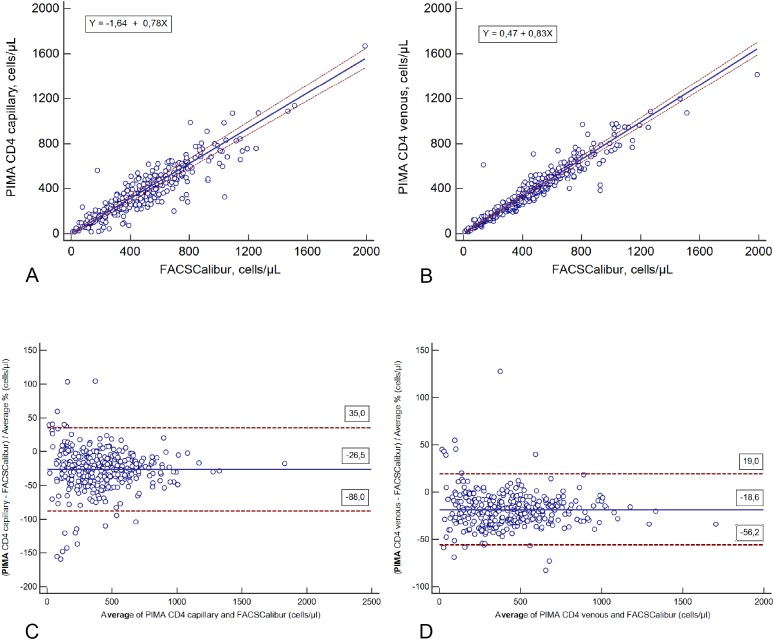
Comparison between the PIMA POC CD4 analyzer using capillary blood or venous blood samples and FACSCalibur.Passing-Bablok regression plots: comparison of absolute CD4 counts obtained by the PIMA POC CD4 analyzer using capillary blood samples (A) and venous blood samples (B) versus FACSCalibur using venous blood samples. The solid blue line represents the regression line and the dashed lines represent the 95% CI for the regression line. The corresponding graphs the relative bias between the PIMA POC CD4 analyzer and the FACSCalibur are represented in Pollock plots for capillary blood samples (C) and venous blood samples (D). The solid blue line represent the mean bias. The dashed lines represent the upper and lower limits of agreement (LOA = mean bias ± 1.96 SD).